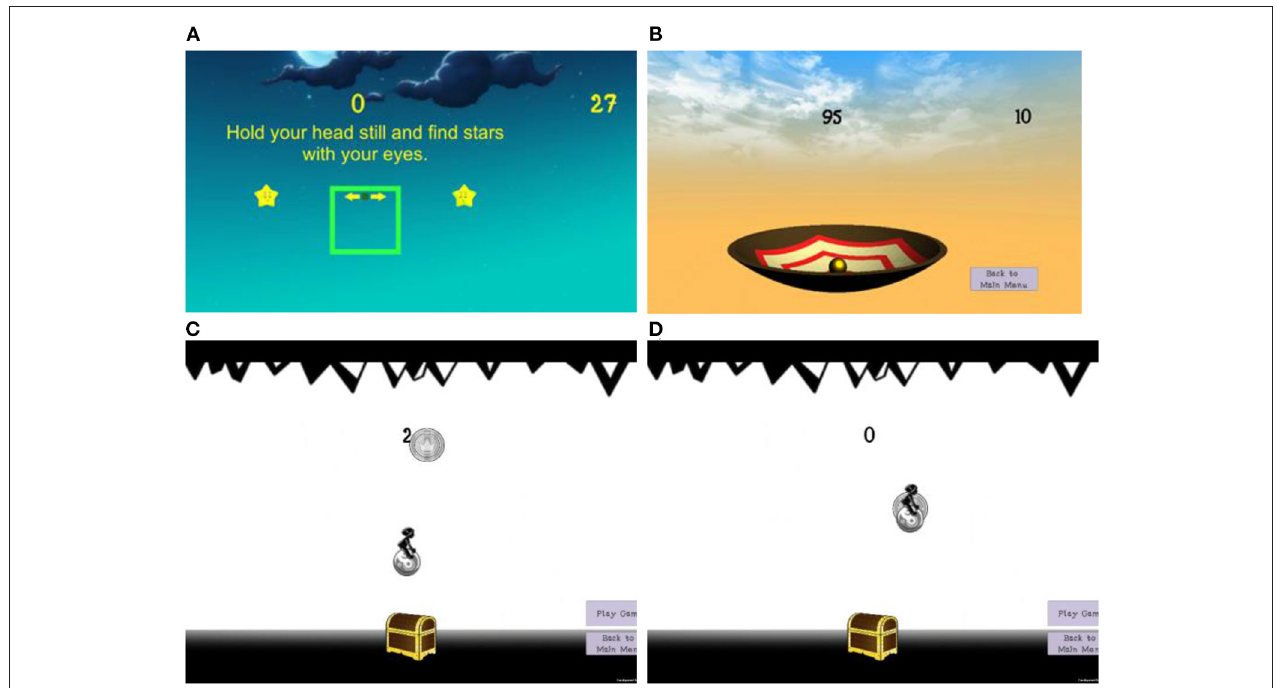
FIGURE 2 | Screenshots of the different vestibular rehabilitation exercise games: (A) gaze shifting, (B) single leg balance, and (C) weight shift with the character moving toward the coin and (D) weight shift with the character returning the coin.